Question: Write the caption for this figure.
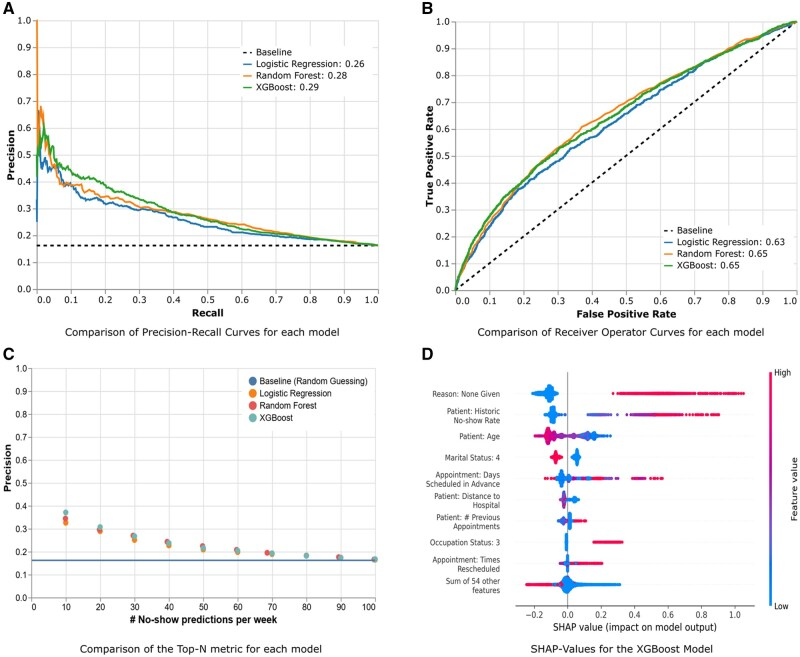
Answer: Results from predictive models. (A) Comparison of precision-recall curves for each model. (B) Comparison of receiver operator curves for each model. (C) Comparison of the top-N metric for each model. (D) SHAP-values for the XGBoost model.